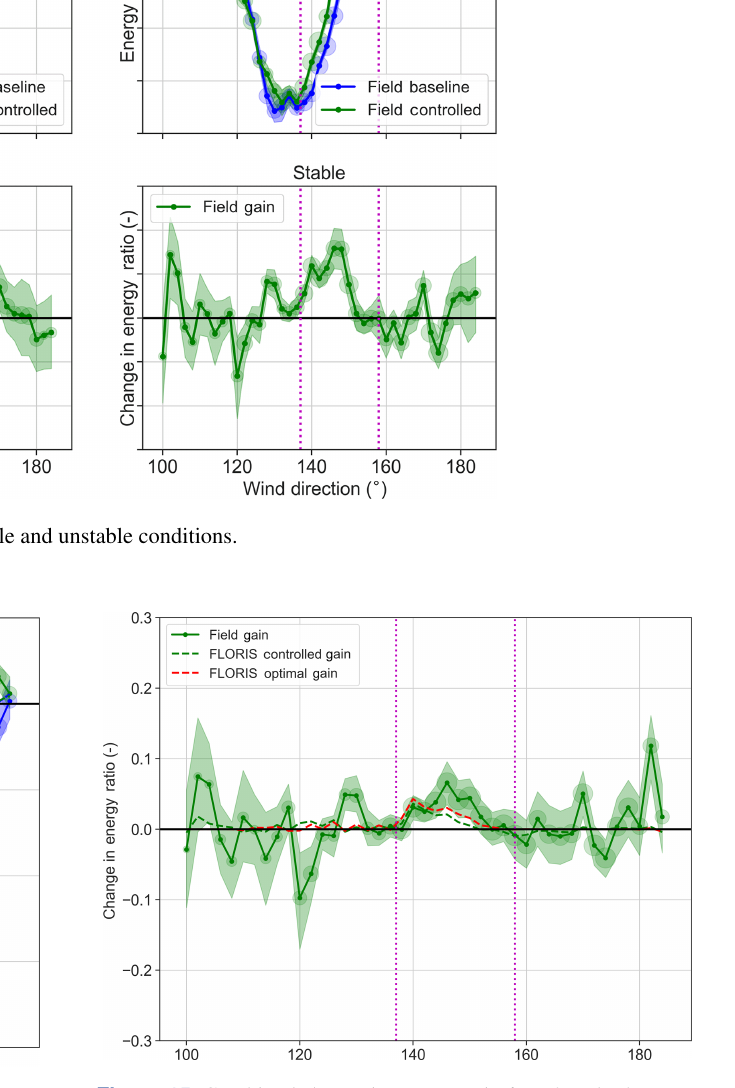
Figure 14. Energy ratio of the summed energy of T3 and T4.